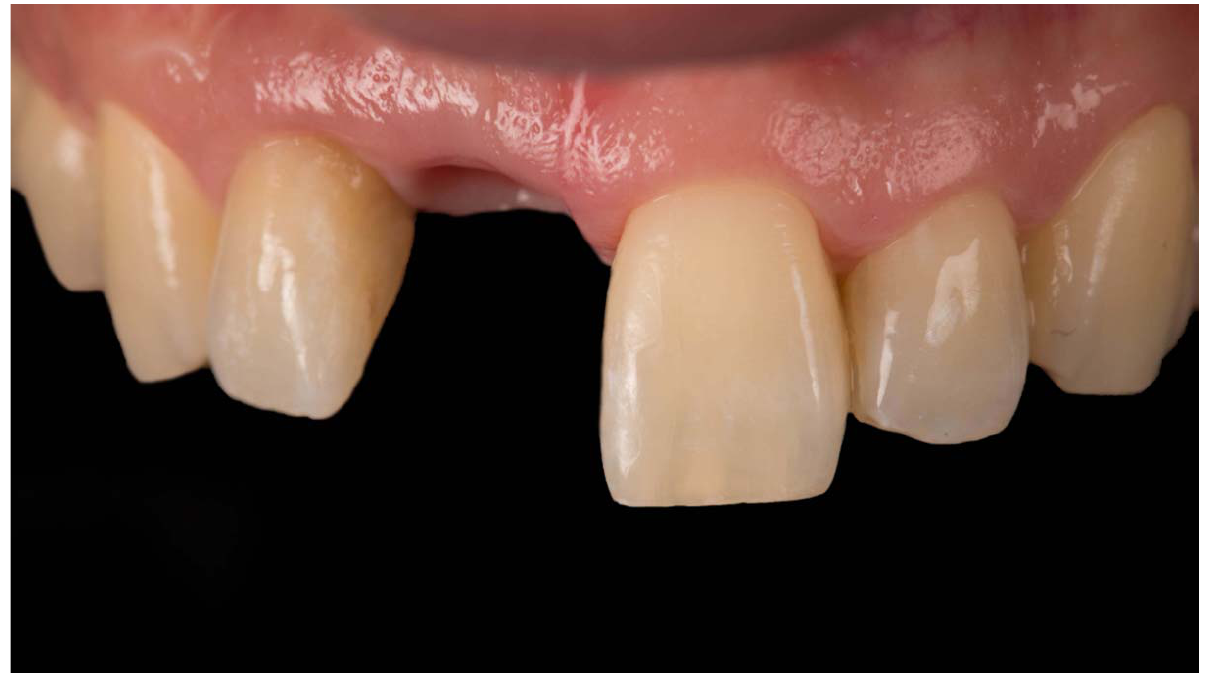
Figure 6. Stable peri ‐ implant soft tissues before screwing the implant ‐ supported restoration. Frontal view.